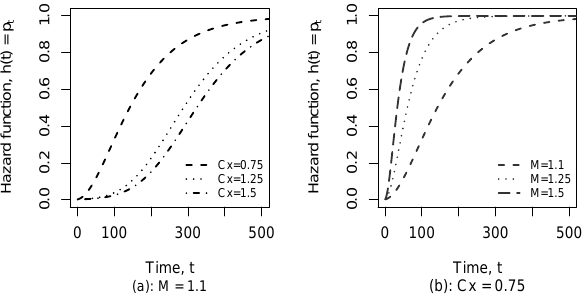
Figure 1. Hazard function h(t) for the nonstationary GP2 model and p o = 0.002 for (a) a range of variability ( C x = 0.75, 1.25, 1.5), given M = 1.1, and (b) a range of trend values ( M = 1.1, 1.25, 1.5), given C x =